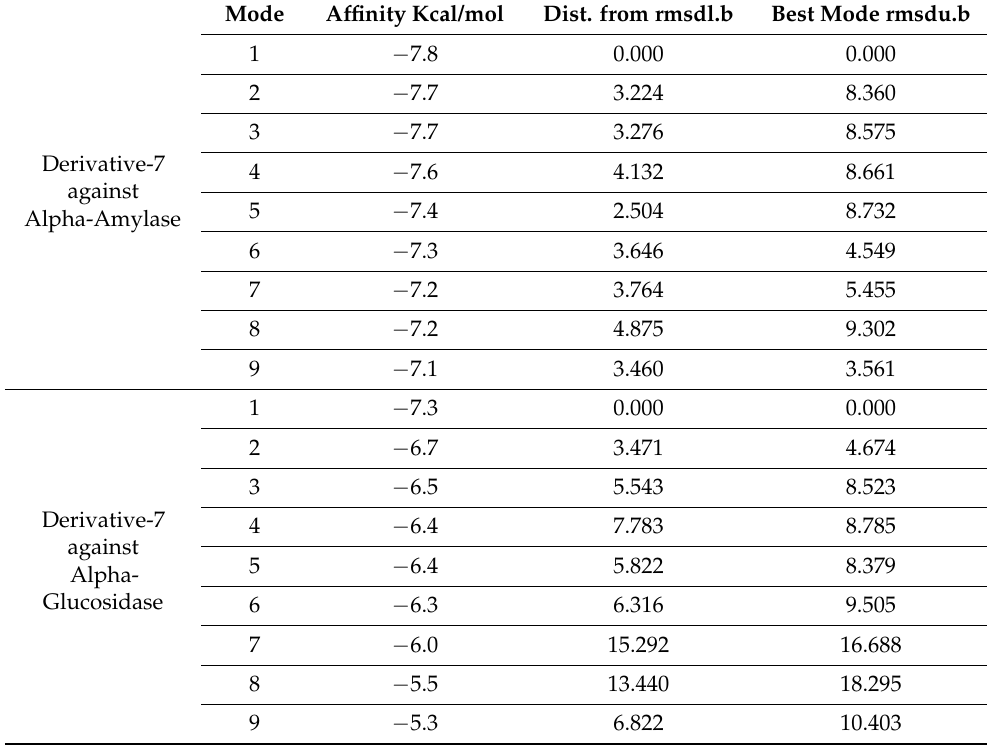
Table 5. Represent the binding affinities and best mode RMSD of analog 7 against Alpha-amylase and